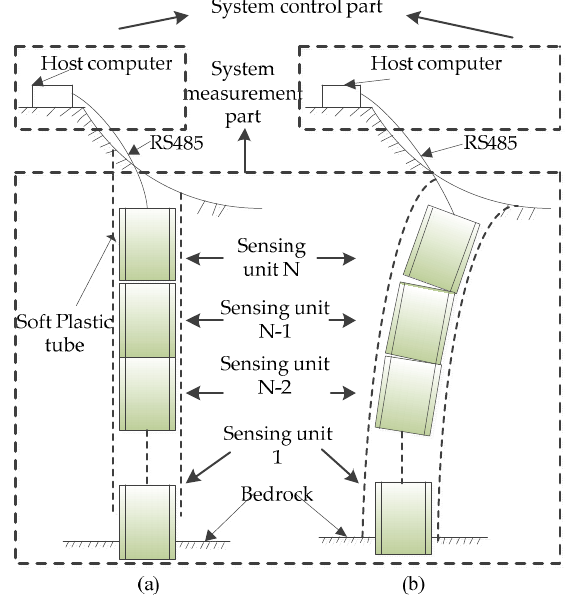
Figure 1. Overall structure of the system. ( a ) Non-sliding rock-soil mass; ( b ) sliding rock-soil mas